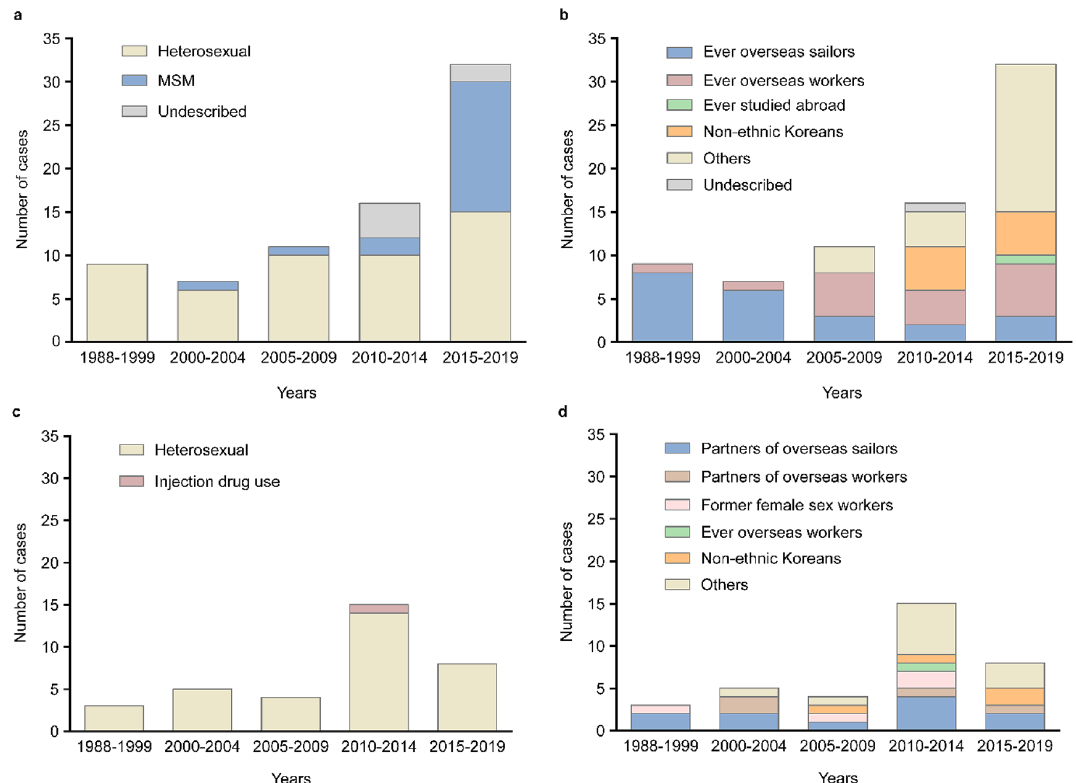
Figure 3. Changes in demographic characteristics of 110 patients with HIV infection harboring non-B subtypes, stratified according to the year of HIV diagnosis. ( a ) Men, route of infection ( b ) men, risk groups for the acquisition of non-B HIV-1 subtypes ( c ) women, route of infection ( d ) women, risk groups for acquisition of non-B HIV-1 subtypes.